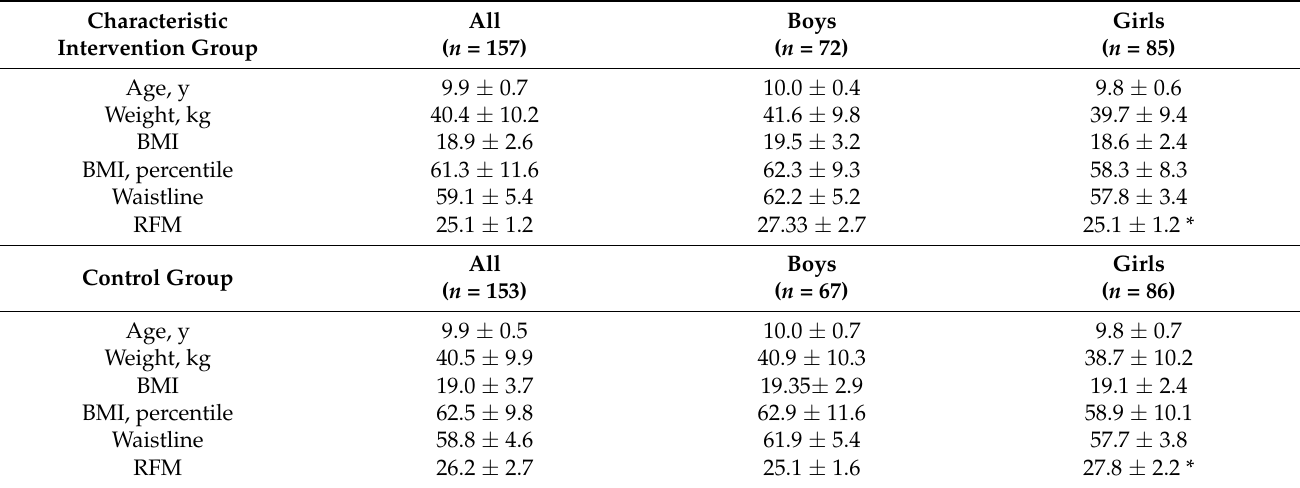
Table 2. Physical characteristic of the children.